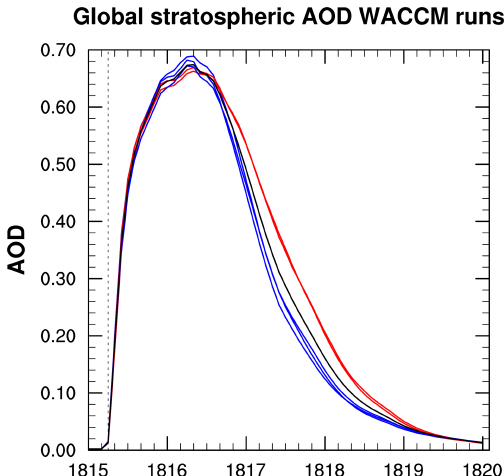
Figure 9. Global stratospheric mean AOD of the five CESM- WACCM ensemble runs. Easterly phase nudged QBO forcing is used from the observed strength starting with 1982 for two runs (red), and from the observed strength starting with 1991 for three runs (blue). The ensemble mean of the five runs is in black. Vertical dotted line marks date of injection of SO 2